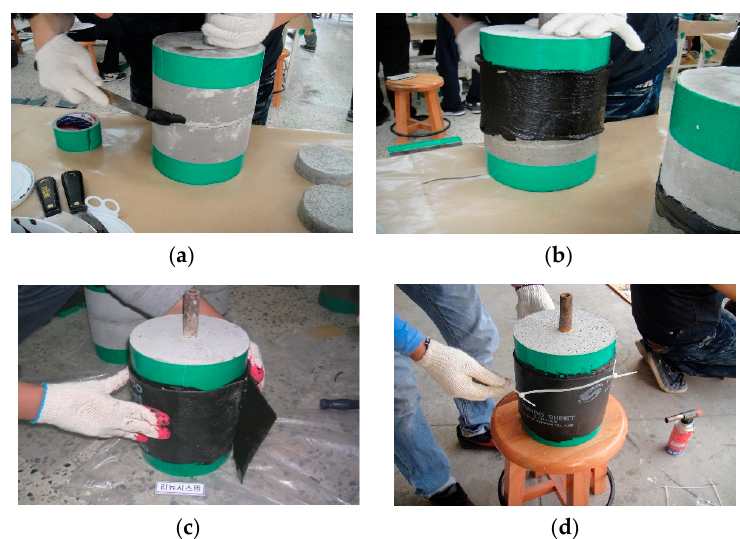
Figure 4. Waterproofing membrane installation dimension.